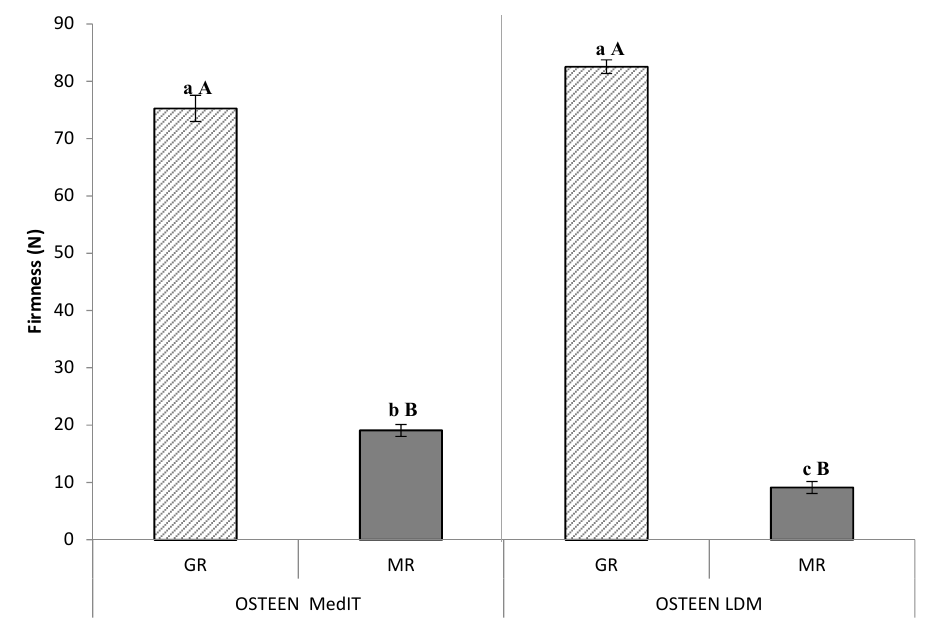
Figure 2. Evolution of fruit firmness in green-ripe (GR) and mature-ripe (MR) fresh Mediterranean Italian (MedIT) and imported (LDM) “Osteen” mango fruit. Values represented as mean ± SE ( n = 30). Different lowercase letters indicate significant differences between imported and fresh Mediterranean Italian mango fruit (GR and MR). Different uppercase letters indicate significant differences between mature-green (GR) and mature-ripe (MR) stages in the same series, fresh Mediterranean Italian fresh mango fruit or imported (Osteen MedIT or Osteen LDM).